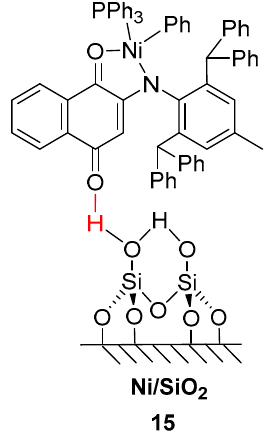
Figure 12. Heterogenization of anilinonaphthoquinone nickel catalysts 15 .